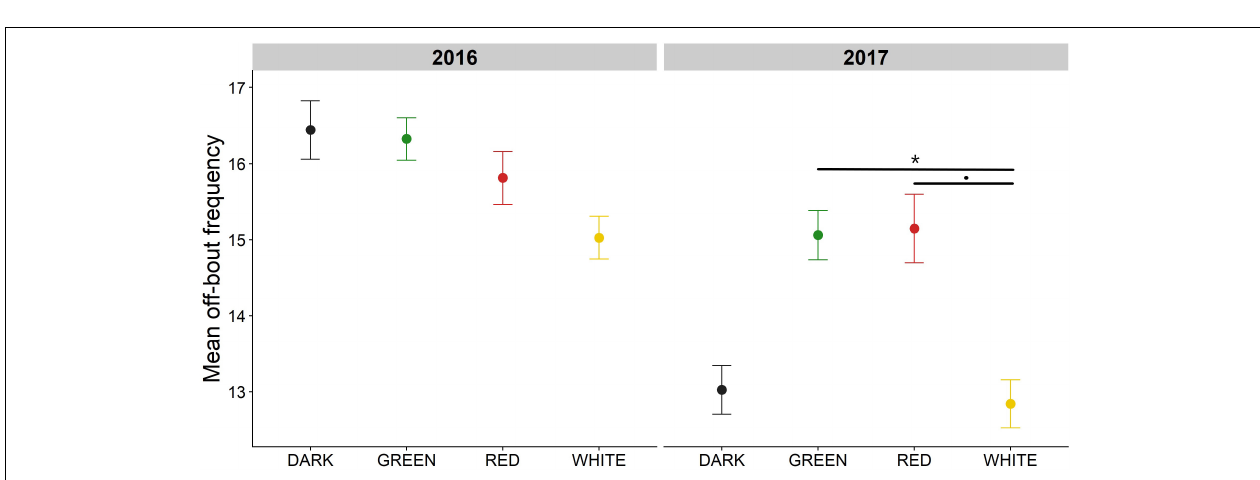
FIGURE 2 | Average day nest temperature in early and late incubation. Raw nest temperature means +-SE are depicted for each artificial light treatment (2016: dark and green N = 14, red N = 17, white N = 16; 2017: dark N = 11, green N = 10, red N = 8, white N = 13 nest boxes). Treatments only differed from each other in the breeding season of 2017 late in incubation (bottom right panel): the average day nest temperature was significantly lower in in the white treatment compared to the green treatment (estimate = − 5.04 ◦ C, t.ratio = − 4.48, P < 0.001), with a trend in the same direction compared to the red treatment (estimate = − 3.47 ◦ C, t.ratio = − 3.00, P = 0.06). The same results were found for mean night nest temperatures ( Supplementary Figure 6 and Supplementary Table 2 ). *** P < 0.001, ◦ P < 0.10.